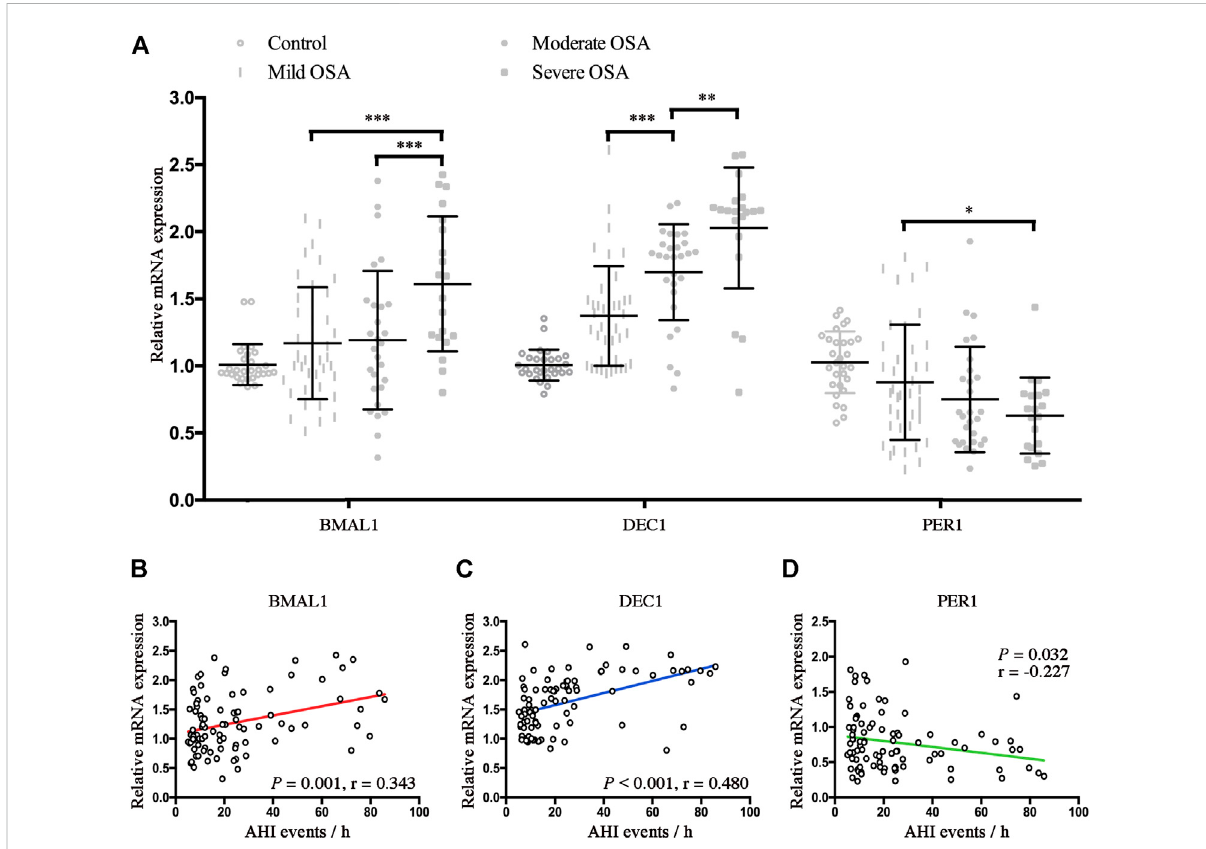
FIGURE 3 CIH isassociated with thedisrupted BMAL1,Dec1, and Per1in OSA. (A) Expression levels ofthedisrupted clock genes (Bmal1, Dec1, and Per1) in theperipheralblood mononuclearcells from control and OSA subgroups (mild,moderate, and severe). (B – D) Linearregression betweenexpression levels of Baml1 (B) , Dec1 (C) , Per1 (D) , and AHI. *, p < 0.05; **, p < 0.01; ***, p <